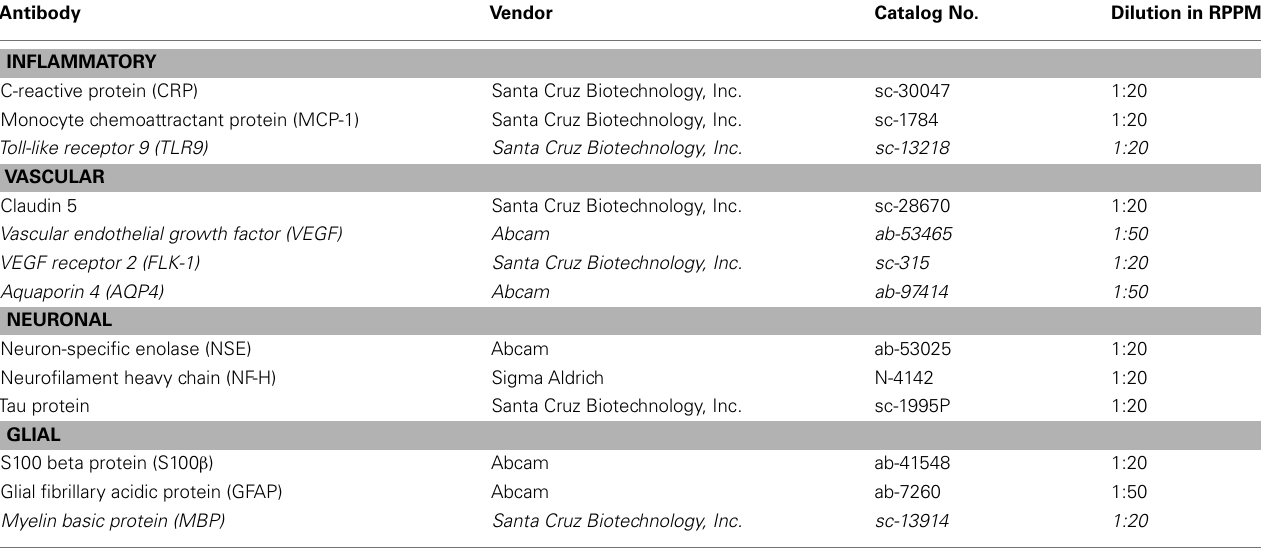
TableA2 | List of antibodies and their respective classifications and dilutions used to measure protein biomarker levels in sera and brain tissues. Antibody